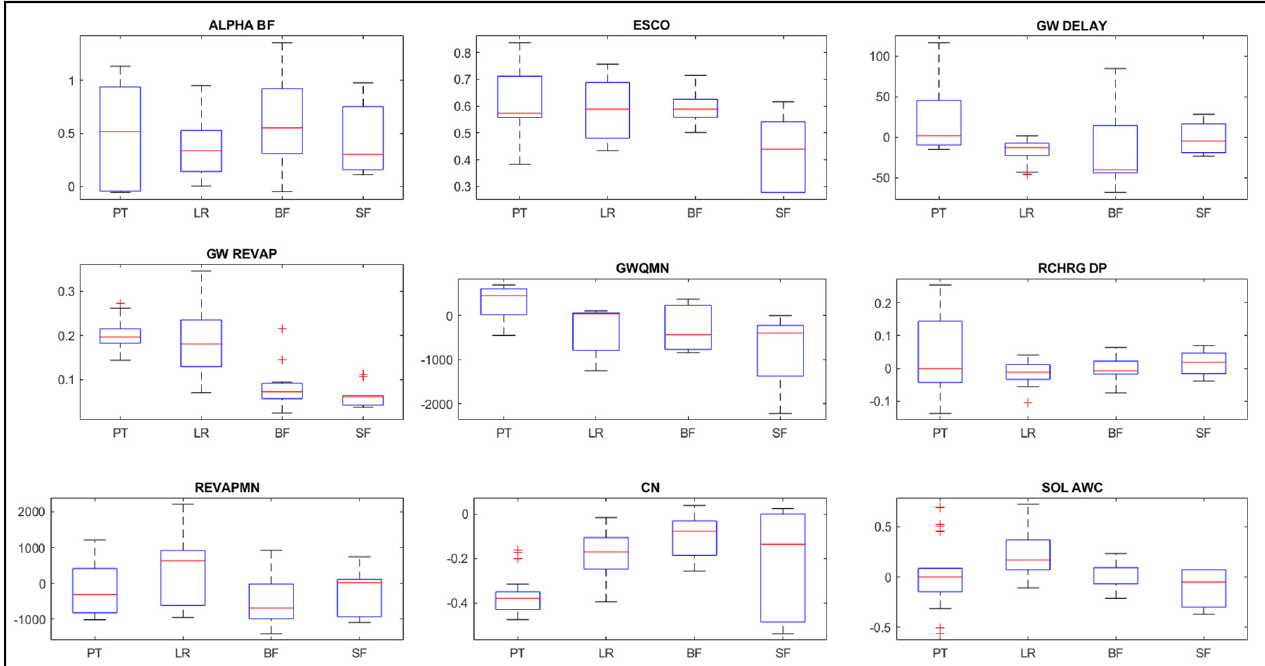
Figure 12. Variation of nine selected influential parameters for the model combinations used in the four watersheds: Peachtree (PT), Little River (LR), Baron Fork (BF), South Fork (SF).